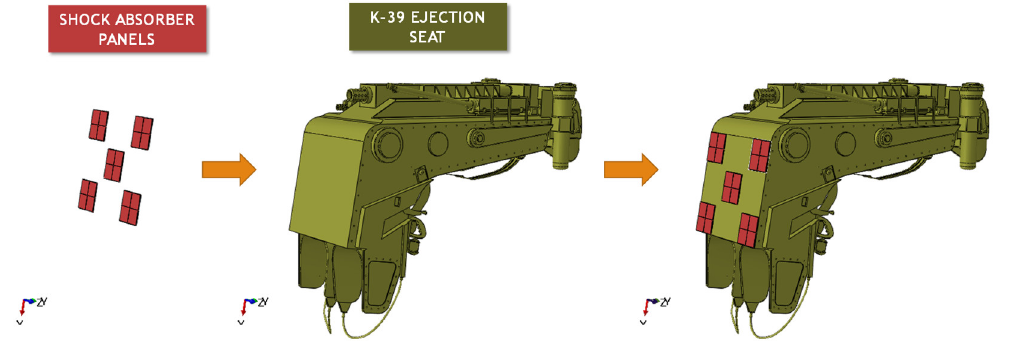
Figure 6. K-39 LT—shock absorber system integration.